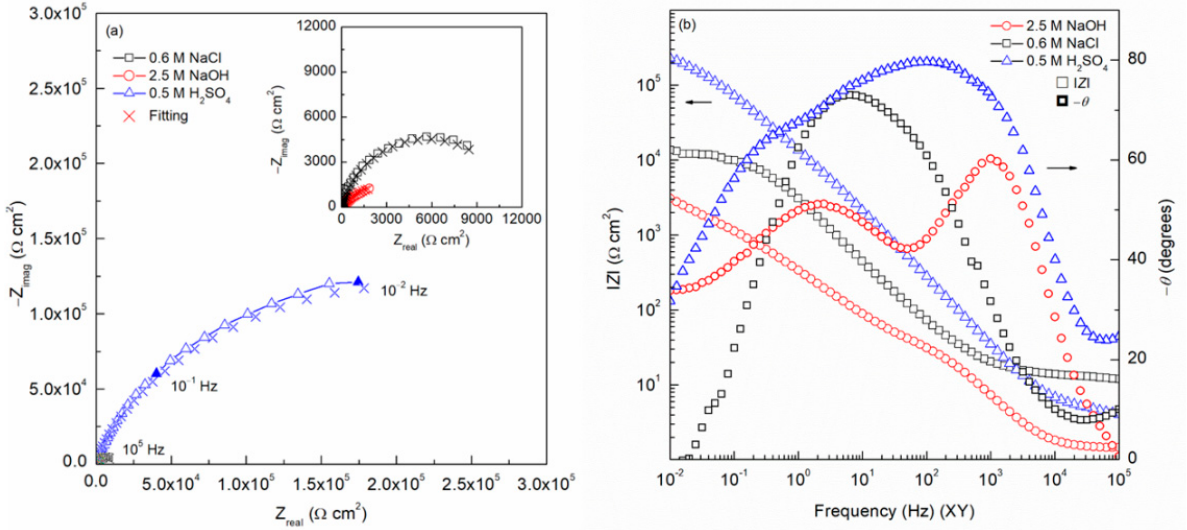
Figure 5. EIS plots for Al 10 Cr 30 Fe 25 Mn 30 Ti 5 HEA in acidic 0.5 M H 2 SO 4 (pH 0.3), neutral 0.6 M NaCl (pH 7), and alkaline 2.5 M NaOH (pH 14) electrolyte solutions: ( a ) Nyquist plots, and ( b ) Bode